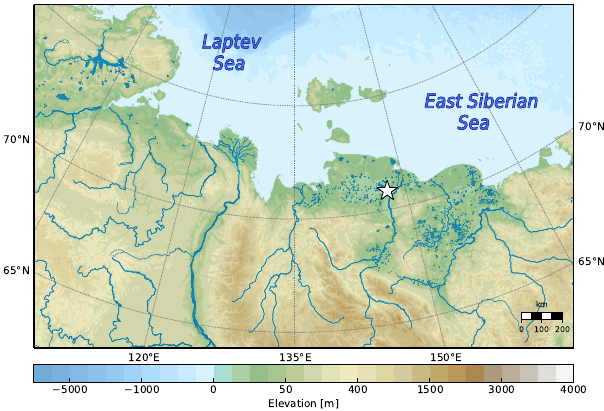
Figure 1. Elevation map of northeastern Siberia. Location of the validation site is marked with a white star. GMRT 2.4 digital eleva- tion model (DEM) was used to create the map (Ryan et al., 2009). Blue lines represent rivers (GSHHG 2.2.4 Wessel and Smith, 1996, and Natural Earth 2.0.0